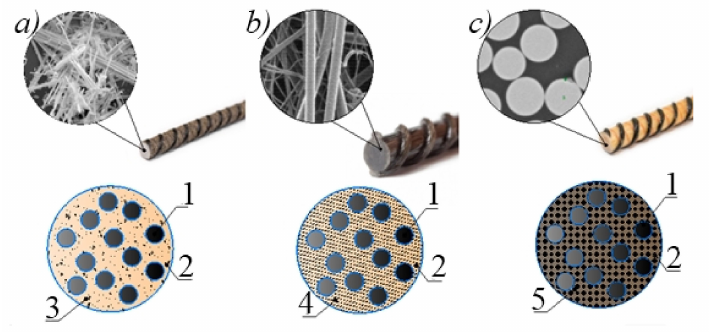
Figure 1. Cross-sectional diagrams of fiber-reinforced plastic (FRP) rebars with inclusions of vari- ous components: ( a ) microsilica (SiO 2 ), ( b ) nanoparticles of aluminum oxide (Al 2 O 3 ), ( c ) micro- corundum, 1—basalt fiber, 2—binder (epoxy resin), 3—microsilica, 4—nanoparticles of Al 2 O 3 , 5—microcorundum.